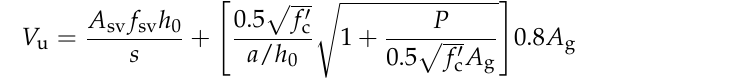
Figure 2. The shear-critical column model based on the uniaxial hysteretic material model [17]. ( a ) Model of shear – bending interaction. ( b ) The displacement response of the column caused by shear and bending deformations.